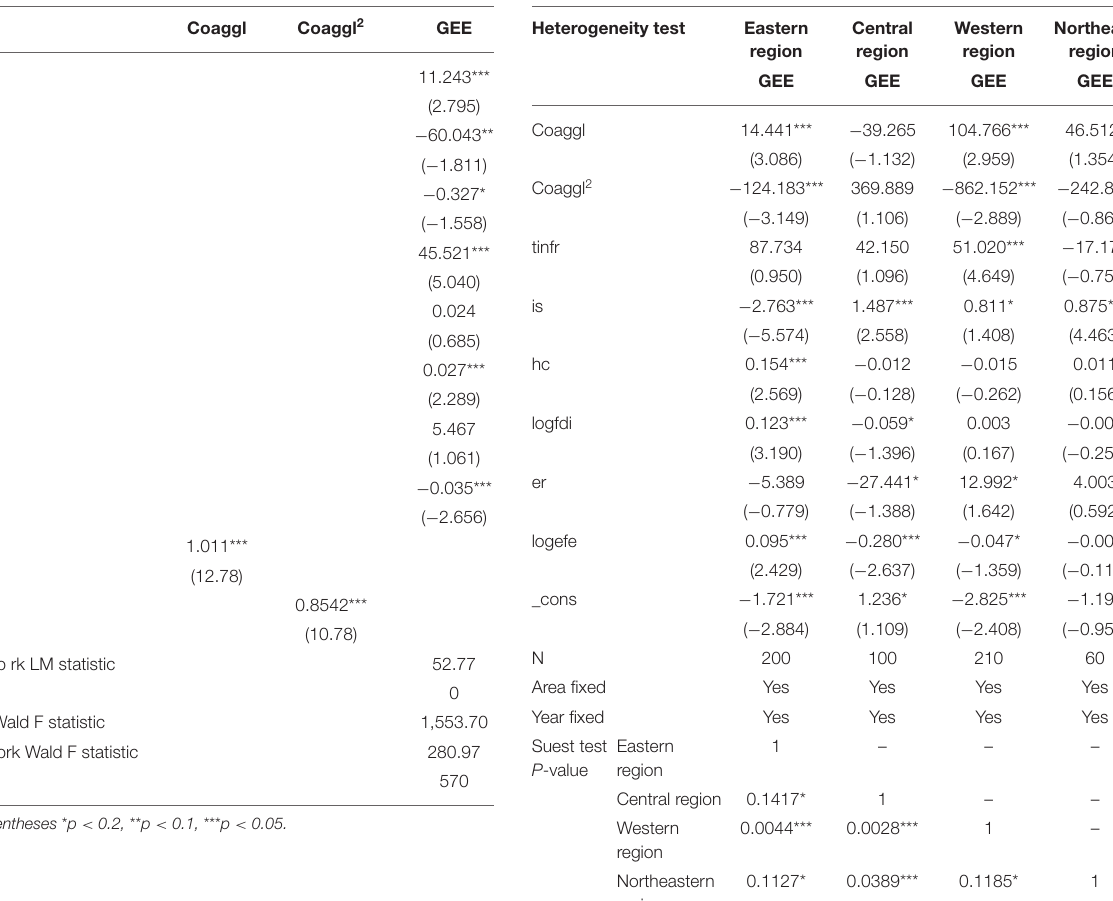
TABLE 3 | Instrumental variable regression. TABLE 4 | Heterogeneity